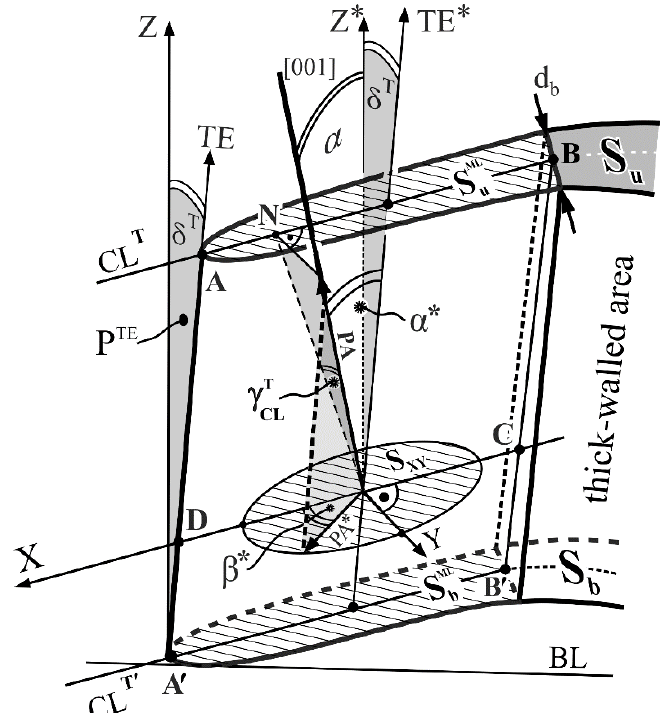
Figure 5. Scheme of the [001] crystallographic direction arrangement which is a primary arm (PA) arrangement in the thin-walled airfoil area ML. The PA unit-vector defines the direction of the primary arm growth. The CL T is parallel to CL T (cid:48) and the X axis; Z is parallel to Z*, TE is parallel to TE*, S ML u is a fragment of Su, S ML is a fragment of Sb; S ML is parallel to S ML u and S XY . b b Table 1. Values of γ T , determined for the S ML and S MM u surfaces, and their di ff erences ∆ γ T , as well CL CL b as the α value, determined for the R b and R u points of an airfoil of blades obtained at di ff erent withdrawal rates. Withdrawal Rate [mm / min.] Parameter